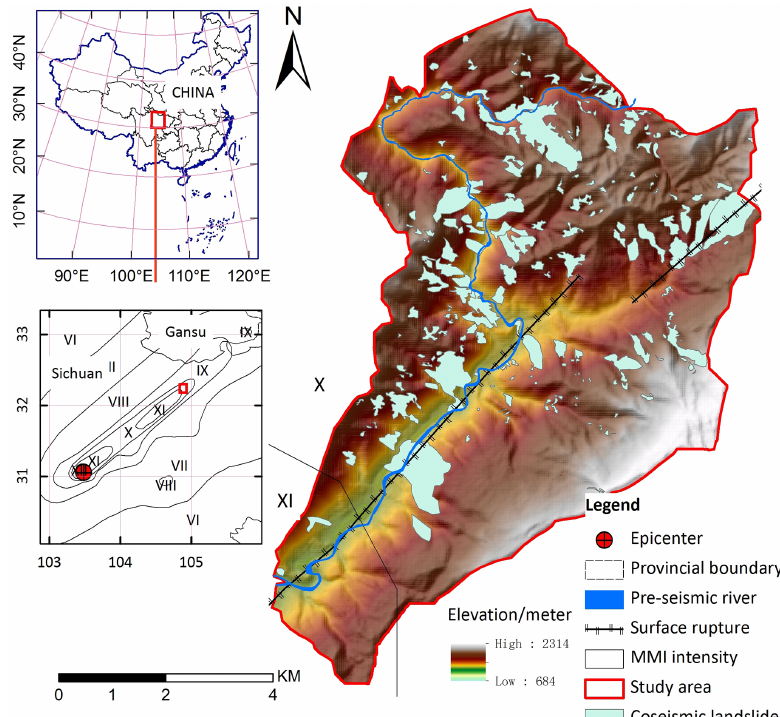
Figure 1. Schematic map of the study area.